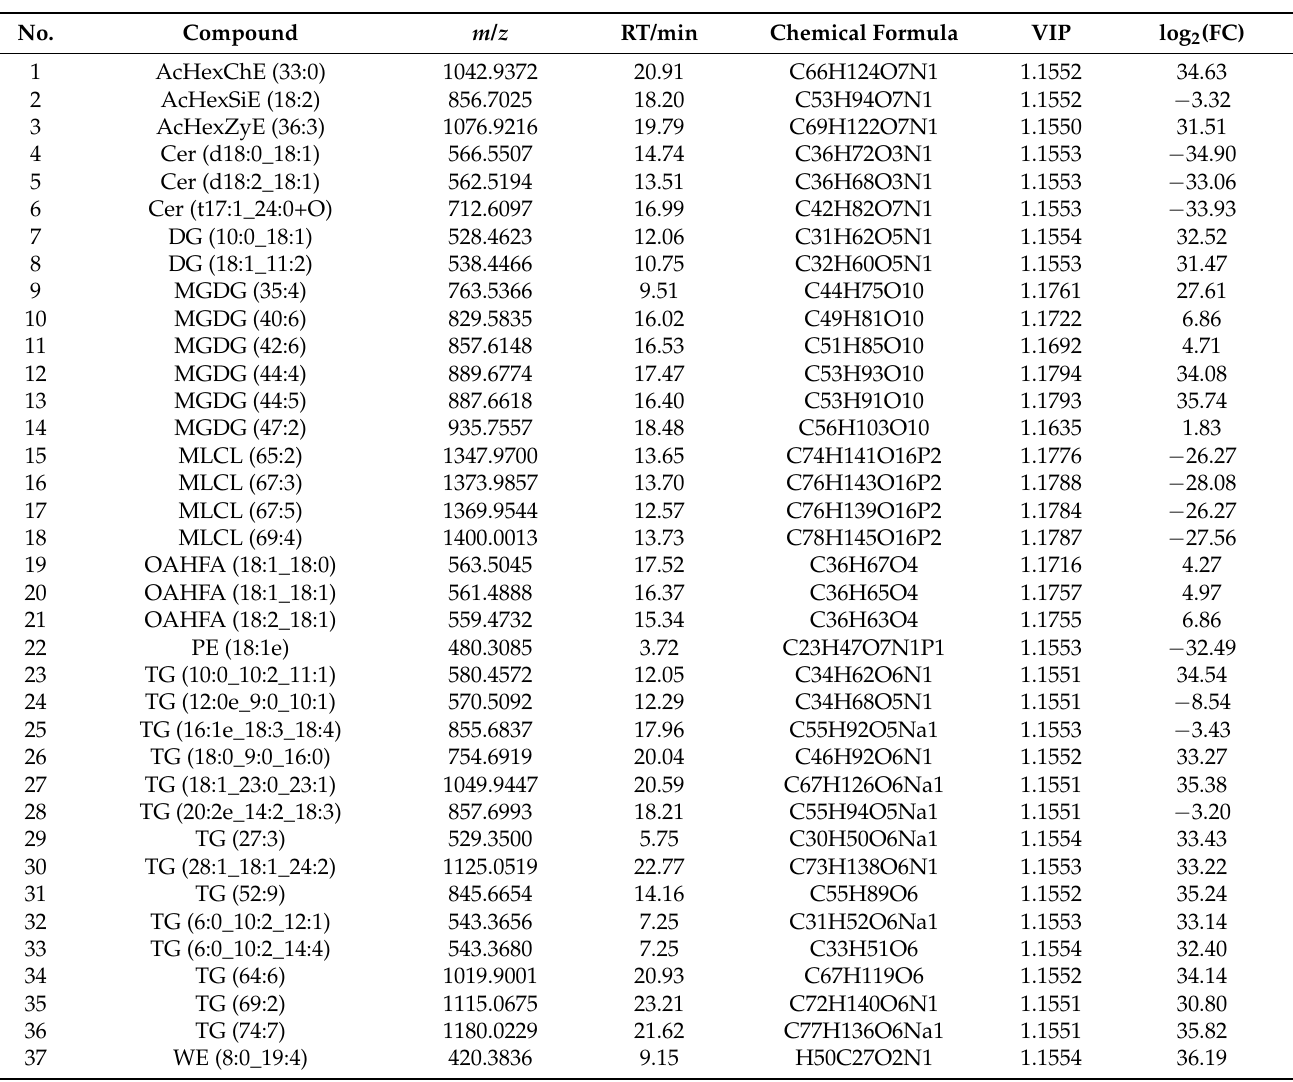
Table 7. Statistical table of specific differential lipids in CO.